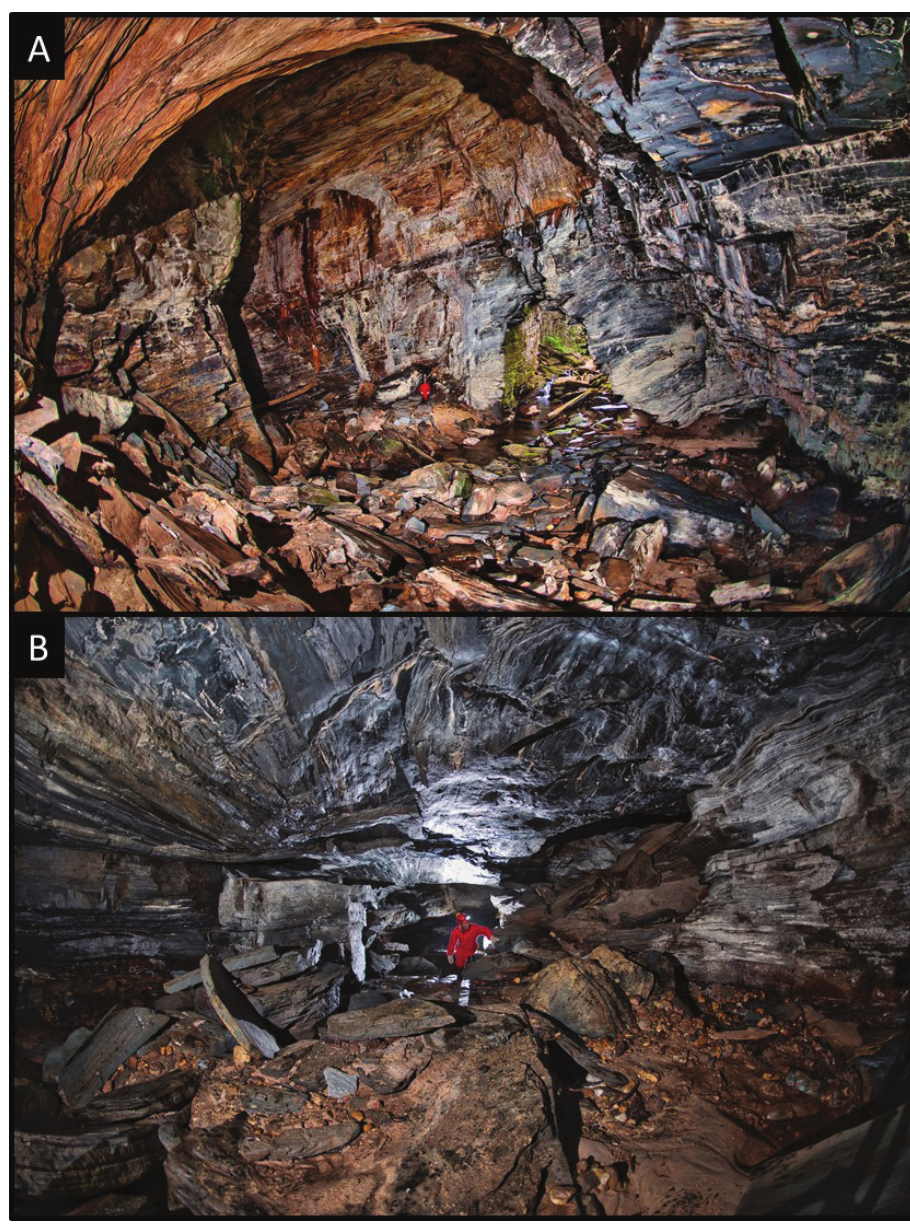
Figure 16. Lapa do Grotão cave, type locality of Ochyrocera rosinha sp. nov. Photos: Ataliba